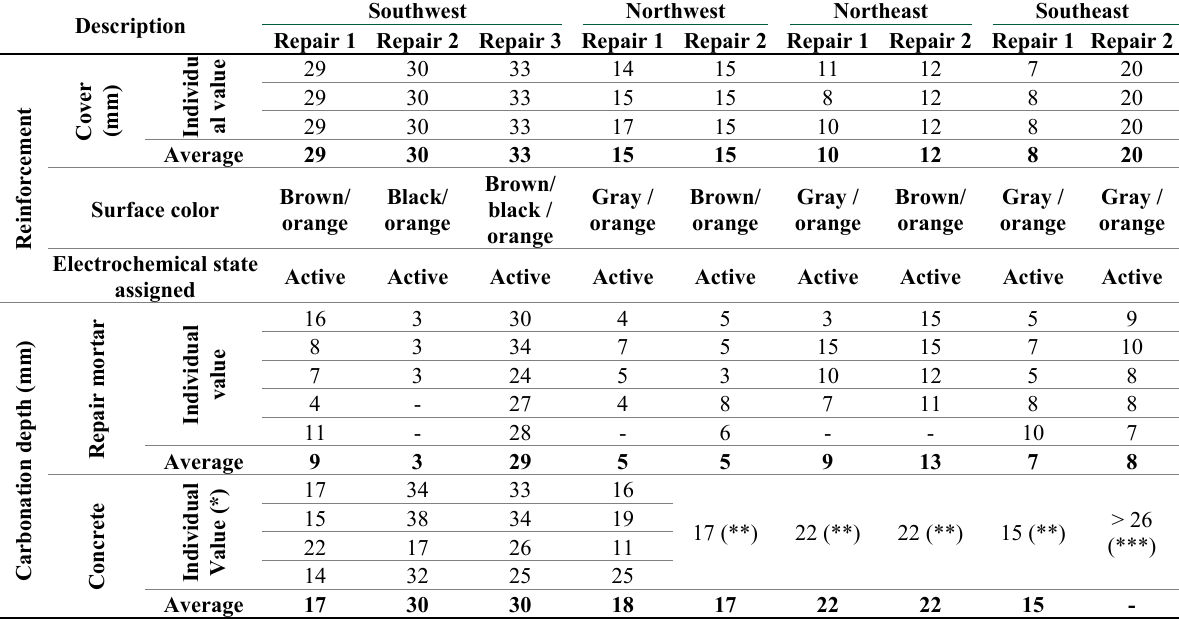
Table 2. Results of inspection of the reinforcement newly exposed in the repair area of the façades; measurements of the cover and carbonation depth.